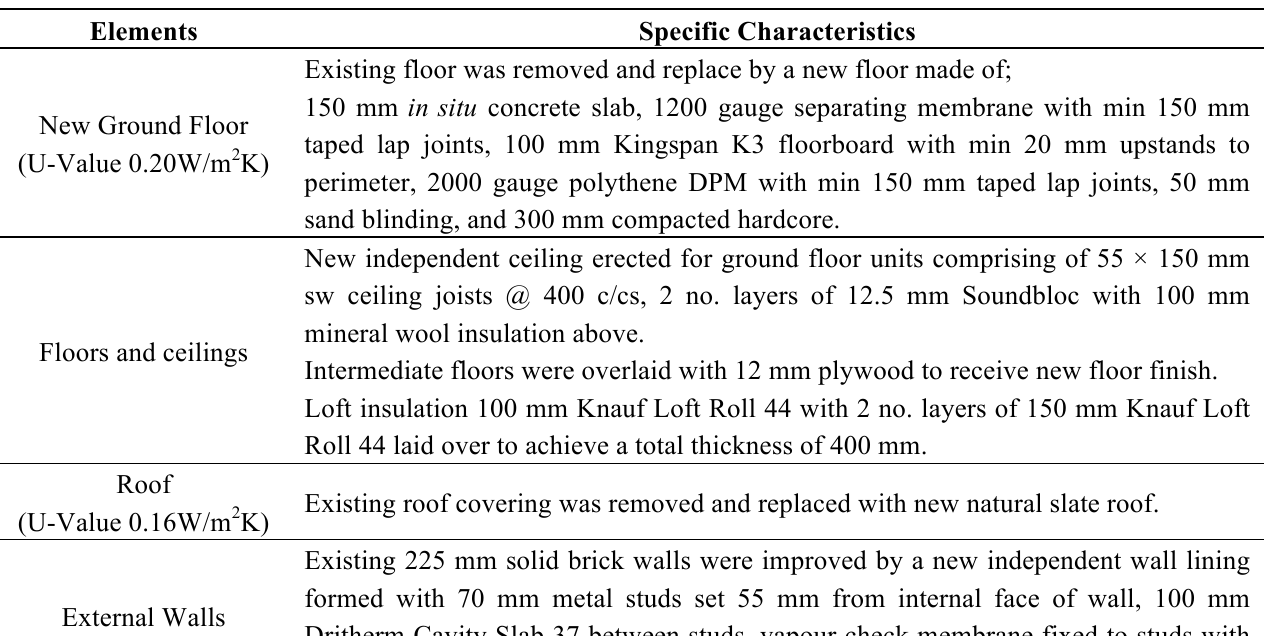
Table 1. Specifications of the main refurbishment measures and new construction